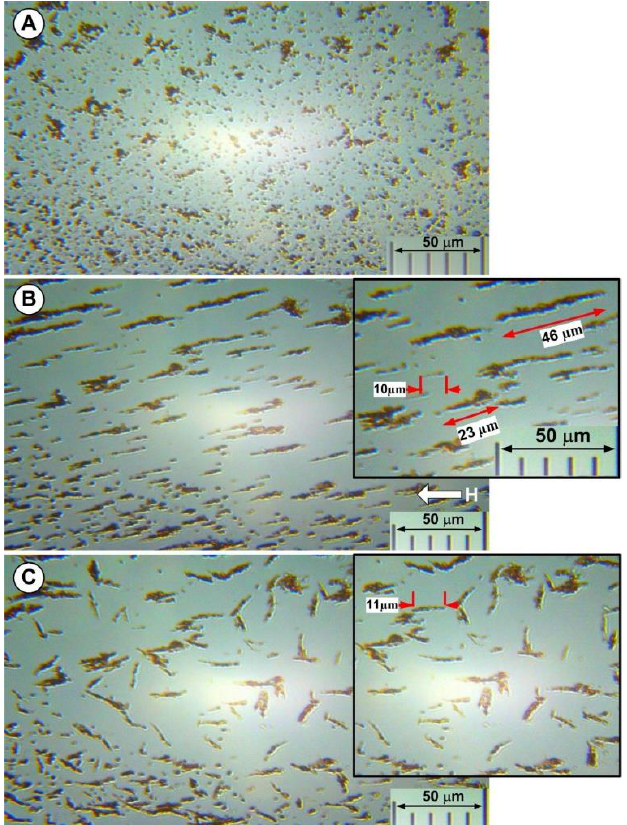
Figure 12. ( A ) PEG_MNC nanocomposite in carrier fluid without the magnetic field (optical microscopy). The figure shows the initial state with a homogeneous nanoparticle suspension when the magnetic field is switched on (t = 0); ( B ) aggregation of the PEG_MNC nanocomposite in carrier fluid under the action of the externally applied magnetic field of intensity H = 110 mT. Detail regarding the length and thickness of different chains generated. ( C ) Evolution of the PEG_MNC aggregate after turning off the magnetic field. Detail shows that the size of nanoparticle aggregates decreases after the magnetic field is turned off.